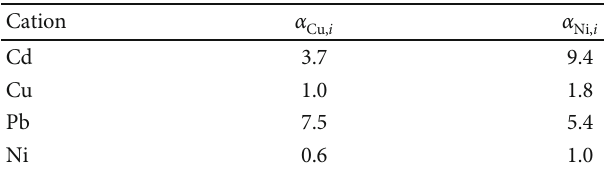
Table 7: Selectivity coe ffi cients of the Schi ff base-modi fi ed aerogel- like